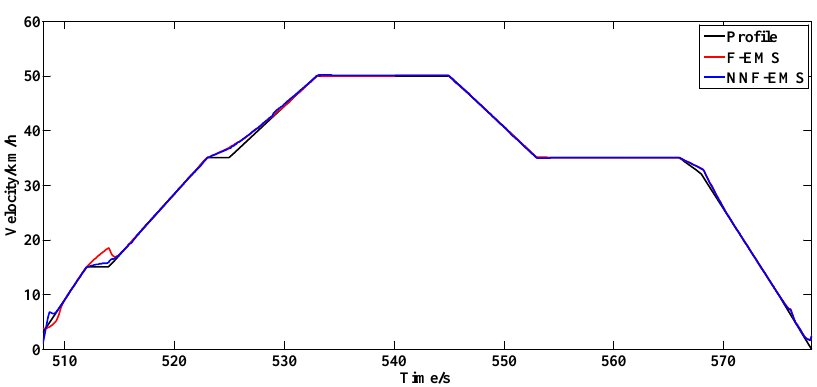
Figure 18. Vehicle velocity following under NEDC cycle (partial enlargement).